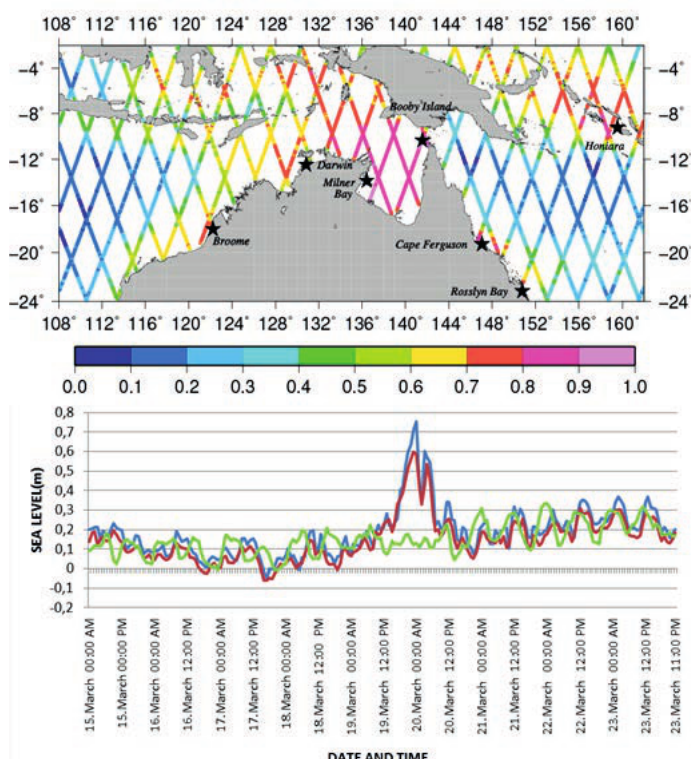
Fig. 6 Upper figure shows the locations of the six gauges used for predicting sea level at Townsville (near Cape Ferguson). The temporal correlation of the non-tidal signal between the tide gauge observations and satellite altimetry is colour coded in the figure. The lower figure shows the sea level observed at Cape Ferguson (blue) and predicted using a multi-regression model from the six other tide gauges only (green) and from including satellite altimetry